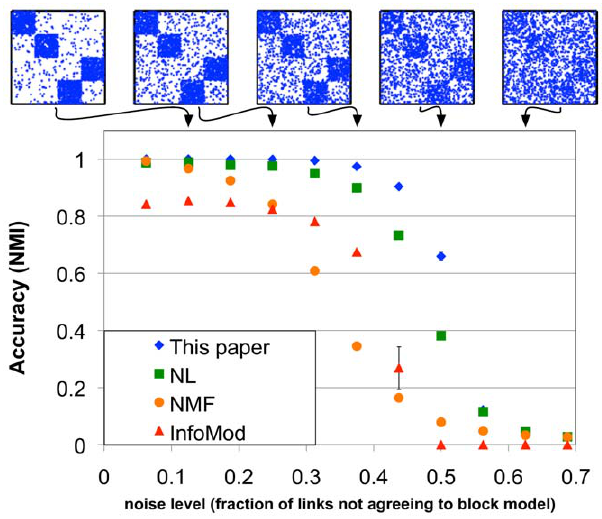
Figure 2. Benchmark on networks with known role structure. We compare our method with a mixture model approach by Newman and Leicht (NL) which employs a maximum likelihood approach [30], a non-negative matrix factorization (NMF) minimizing the Kullback- Leibler-divergence between data and estimated factors [32], and an approach based on minimum description length by Rosvall and Bergstrom (InfoMod) [31]. The adjacency matrices show typical realizations of the test networks with rows and columns ordered according to the designed classes. Accuracy is measured in terms of normalized mutual information (NMI) between the designed assign- ment of nodes into classes and the classification inferred by the algorithms. Clearly, our approach outperforms the alternatives, in particular for high noise levels.